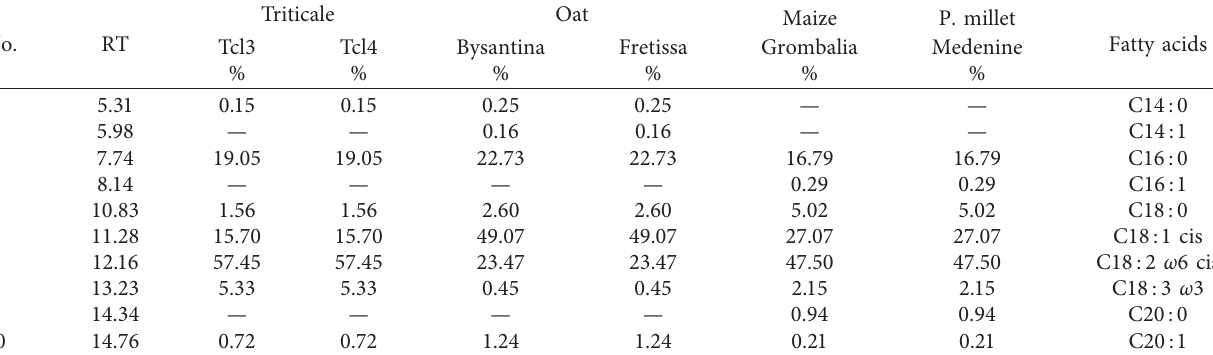
Table 6: Fatty acid composition (%: relative percent) and retention time (RT, min) of triticale, oat, maize, and pearl millet varieties. Triticale Oat Maize P. millet No. RT — 0.16 0.16